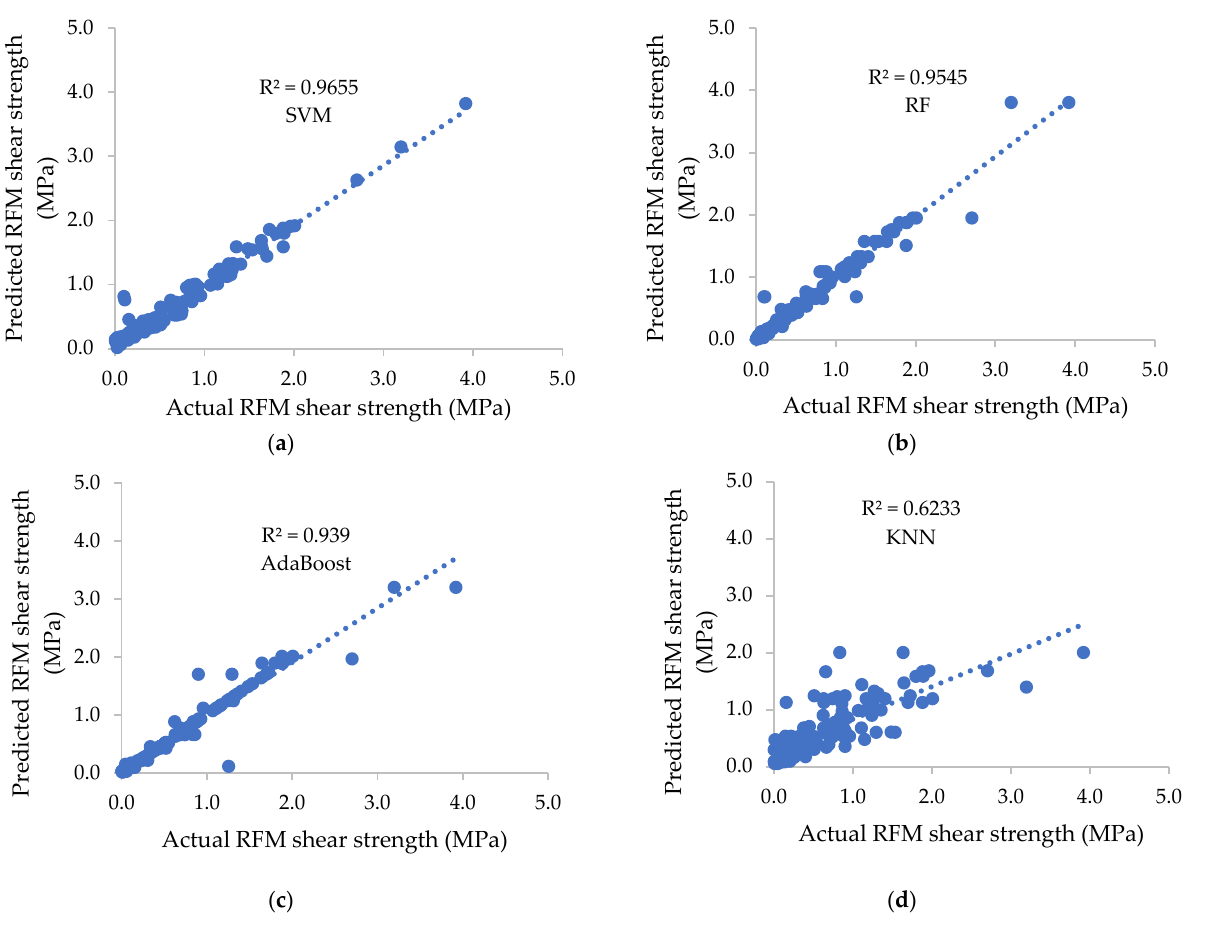
Figure 3. Scatter plots of actual vs. predicted RFM shear strength in training stage: ( a ) SVM, ( b ) RF, ( c ) AdaBoost, and ( d ) KNN.